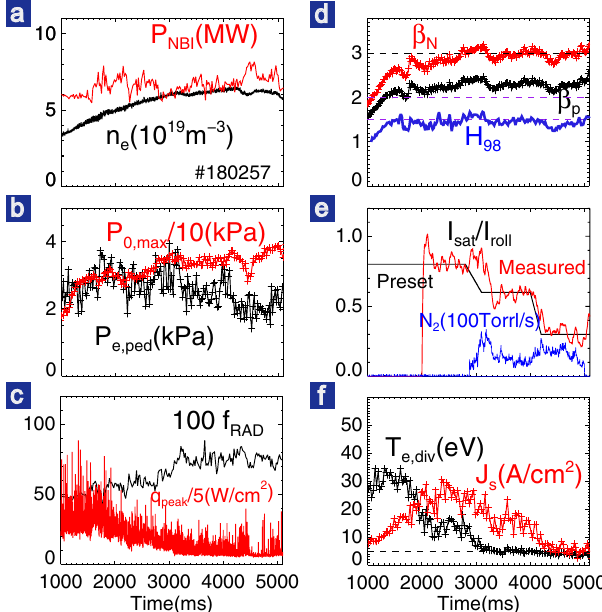
Fig. 1 Plasma parameters for a high- β p discharge (#180257) with active feedback control of detachment via N 2 seeding. a NBI heating power (red) and line-averaged density. b The peak electron pressure (red) and pedestal top electron pressure (black) measured by the Thomson scattering system. c Fraction of radiation/NBI power and IR peak heat fl ux (red). d β N (red), β p (black), and H 98 (blue). e Preset and measured I sat / I roll for divertor detachment feedback control, nitrogen gas puf fi ng rate. f Peak particle fl ux and T e near the outer strike point, with 1 A/cm 2 corresponding to particle fl ux of 6.24 × 10 22 m − 2 s − 1